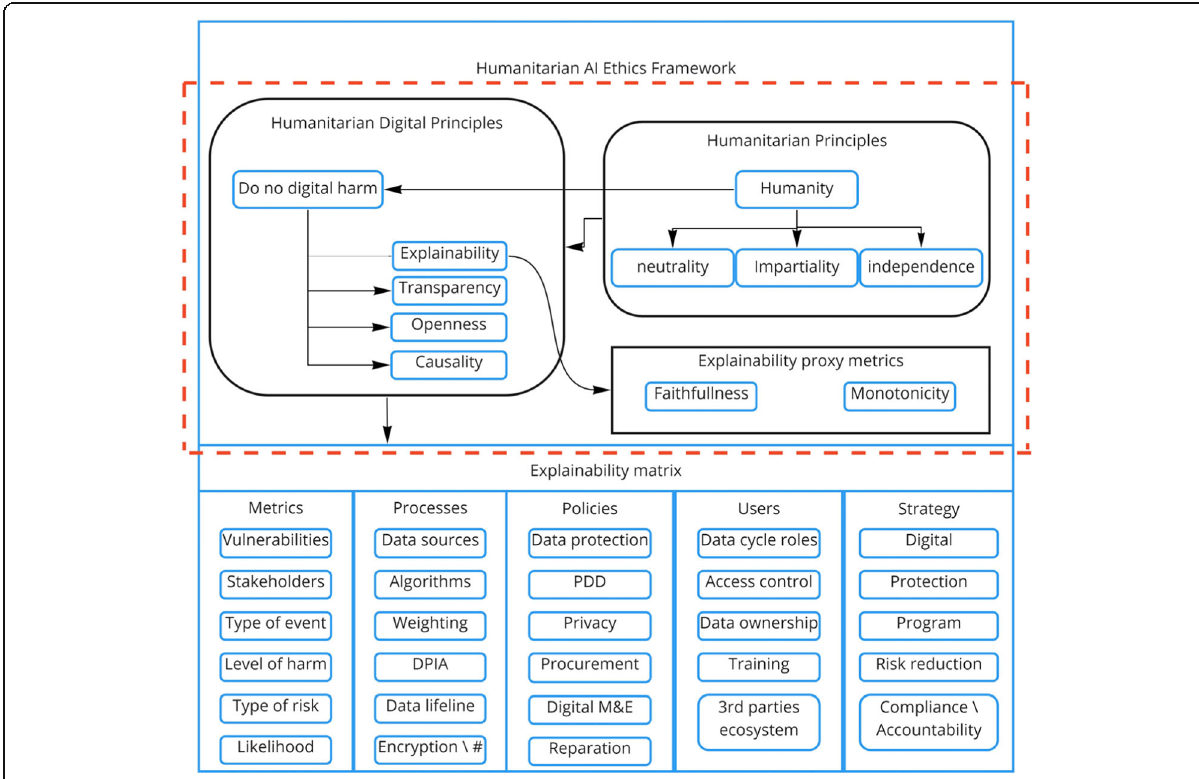
Fig. 1 Scope of article (dotted red line) and proposed matrix for future